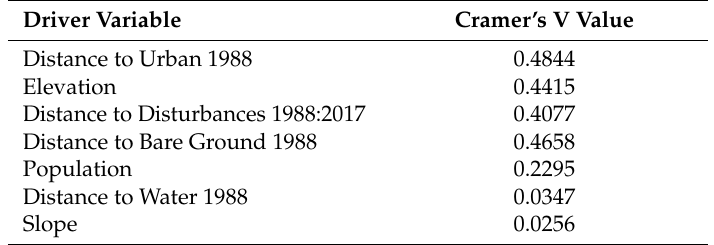
Table 1. Examined driver variable’s Cramer’s V values for 1988:2017 model including the desert and the cultivated lands flanks.